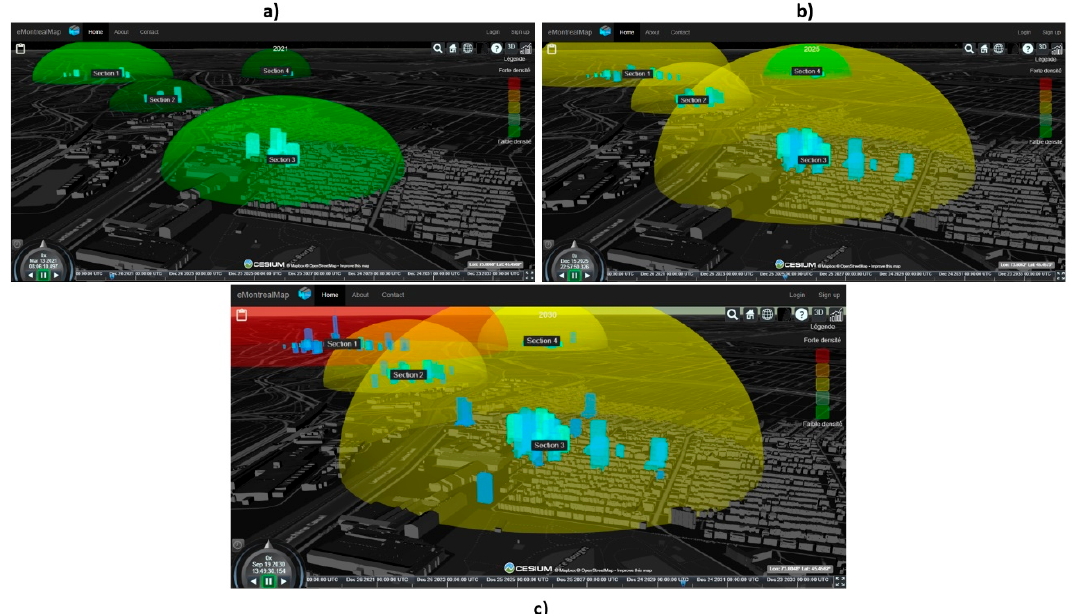
Figure 6. All four neighborhoods with proposed high-rise buildings and projected population density at different periods: ( a ) 2020, ( b ) 2025, and ( c ) 2030.